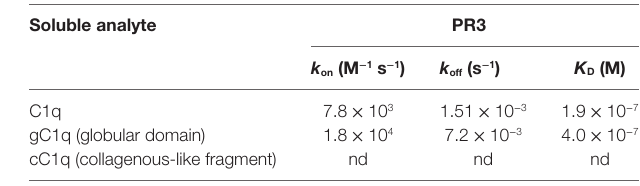
TaBle 1 | Kinetic constants for the binding of C1q to immobilized proteinase 3 (PR3).